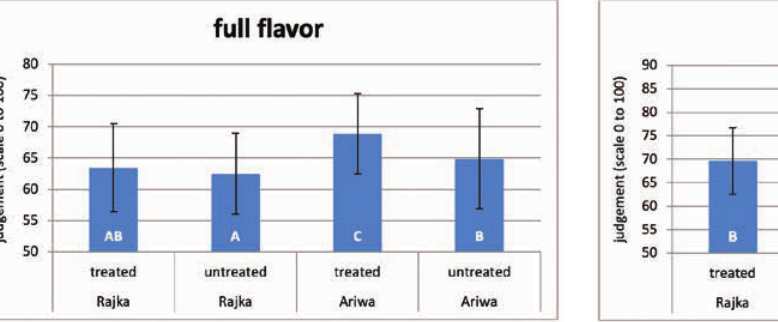
Figure 5: Freshness (mean ± SD, n without a same letter vary significantly, p ≤ 0.05)